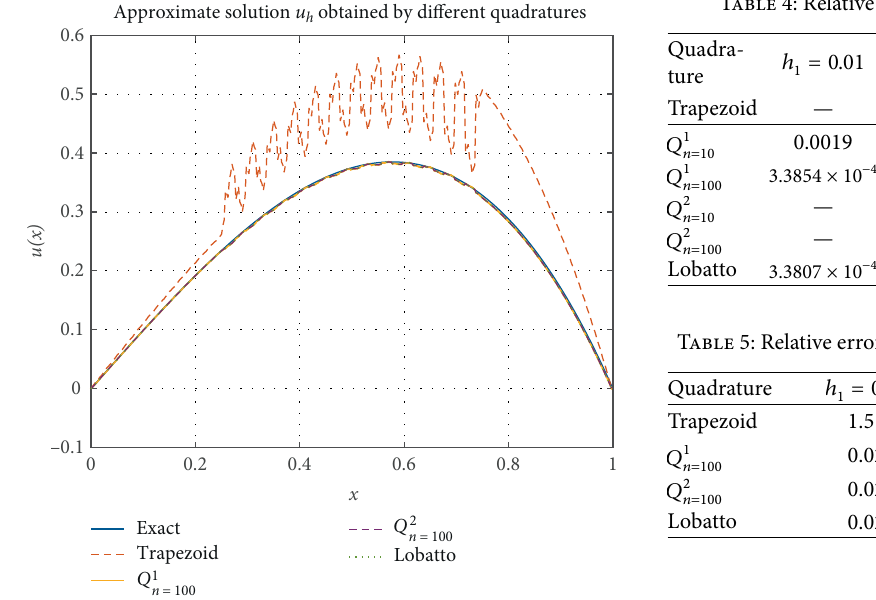
vs approximate solutions 𝑢(𝑥)